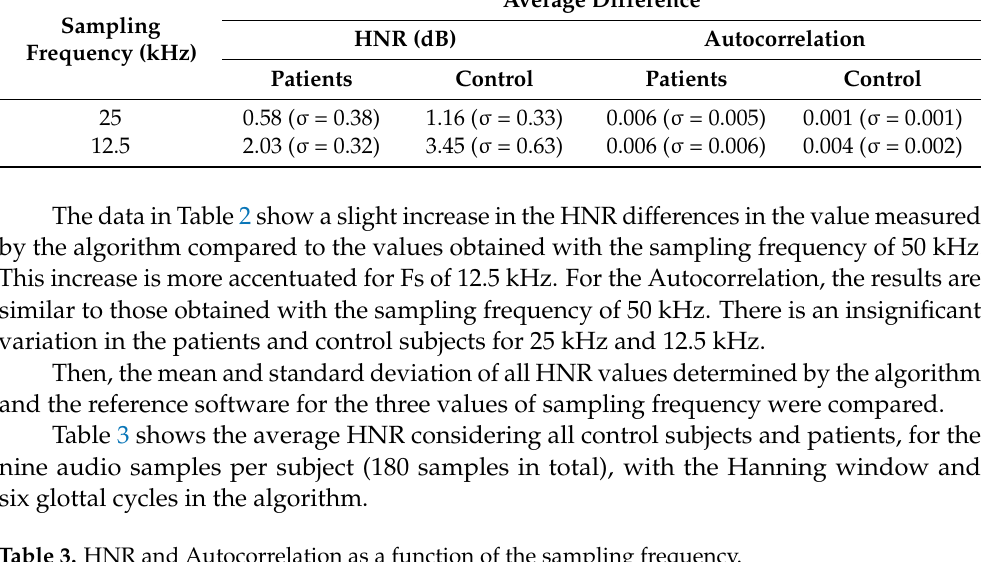
Table 3. HNR and Autocorrelation as a function of the sampling